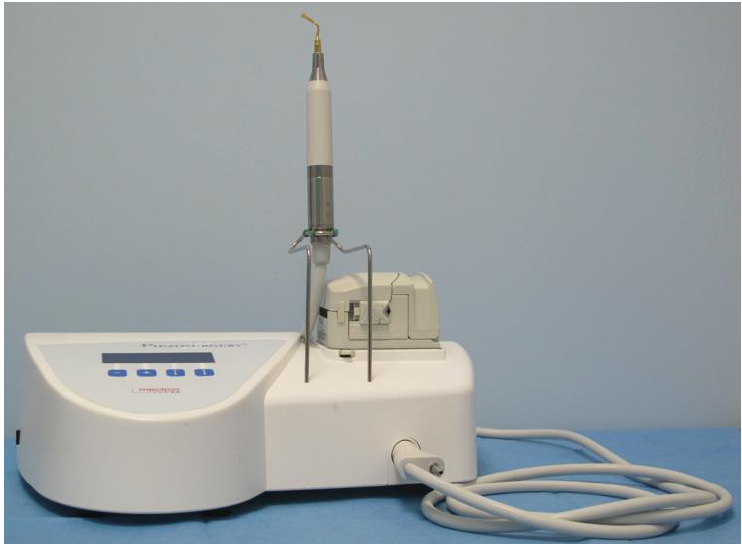
Figure 1. Piezoelectric cutting tool device (Mectron S.P.A., Carasco-Genova, Italy).